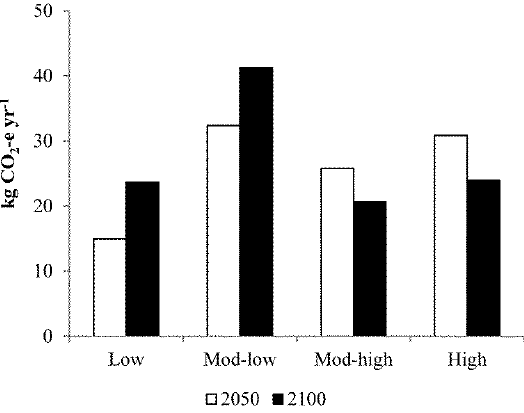
Figure 5. GHG emissions (kg CO 2 -e yr-1) per kg of displaced lettuce under the four future scenarios at time horizons 2050 and 2100. time horizons 2050 and